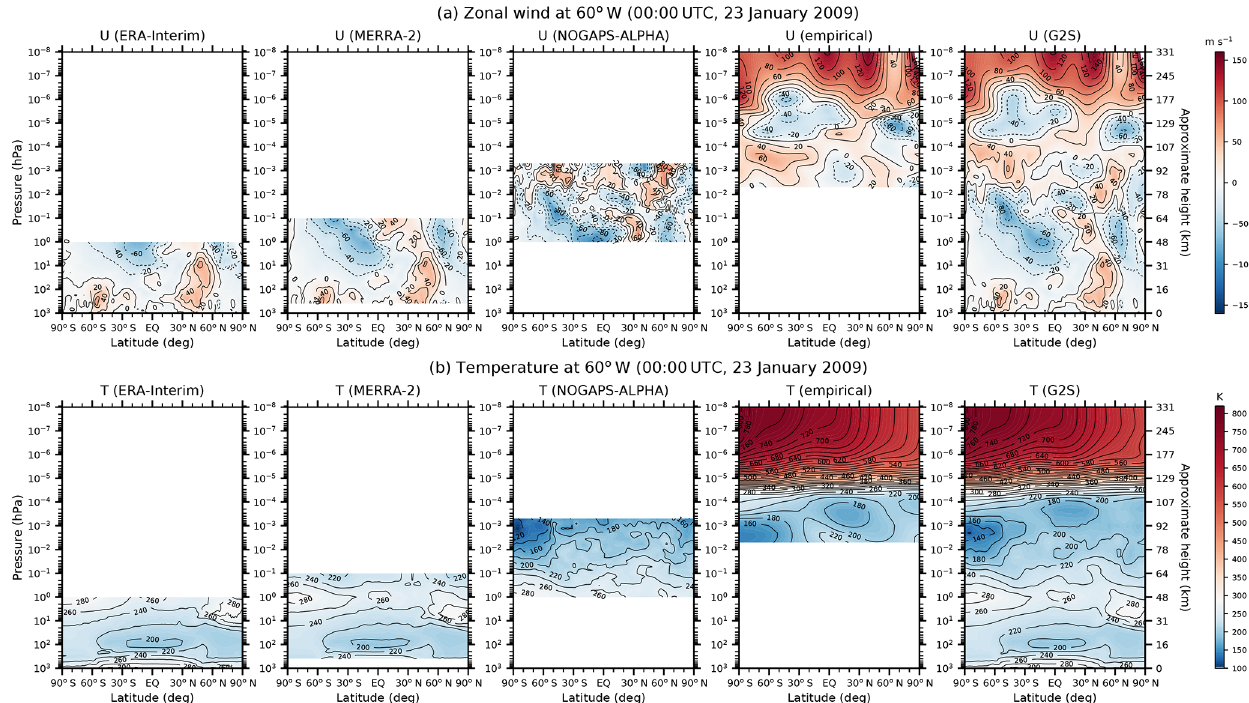
Figure 1. Latitude–height cross sections of (a) zonal wind and (b) temperature in the ERA-Interim, MERRA-2, NOGAPS–ALPHA, empir- ical models, and G2S data at 60 ◦ W at 00:00UTC on 23 January 2009. For zonal wind, shading and contour intervals are 2 and 20ms − 1 , respectively. Contours for westward winds are plotted in broken lines. For temperature, shading and contour intervals are 5 and 20K, respec-